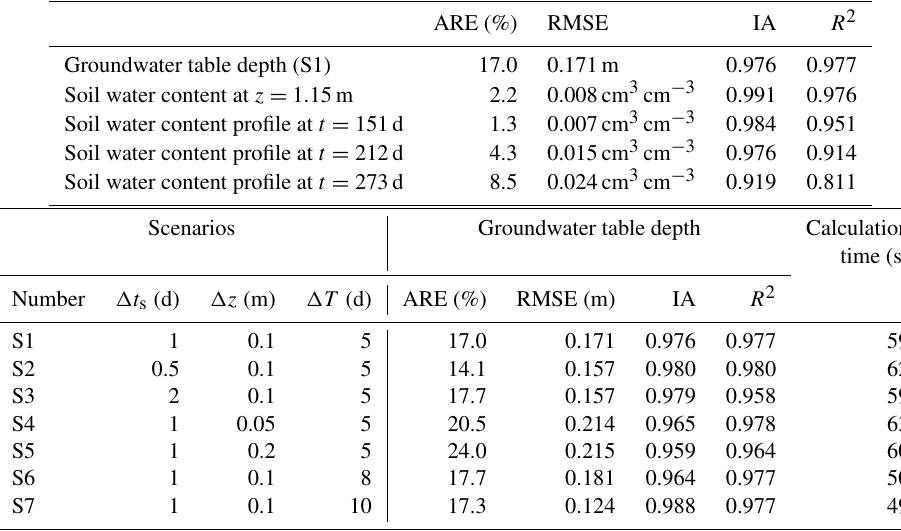
Table 2. The statistical index values of the coupled model of case